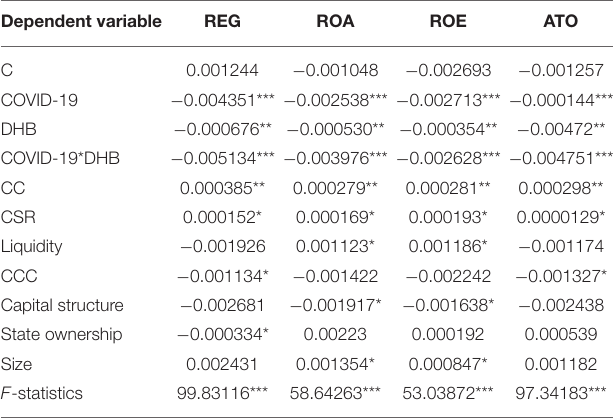
TABLE 9 | Generalized linear regression in Hubei